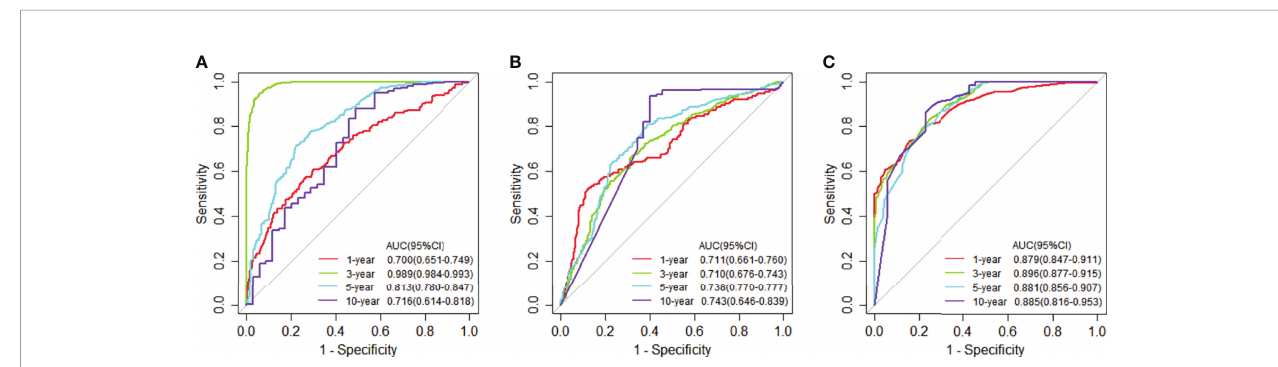
FIGURE 3 | Time-dependent receiver operating characteristic (ROC) curves at 1, 3, 5, and 10 years of mRNA expression data in TCGA. (A) The ROC curves for JDINAC classi fi er. (B) The ROC curves for logistic regression classi fi er. (C) The ROC curves for random forest classi fi